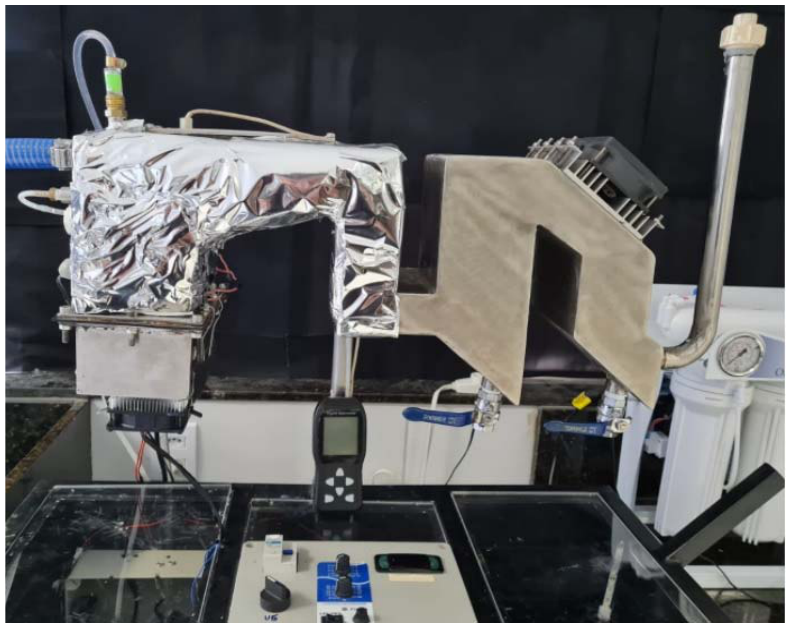
Figure 2. Bench ‐ scale prototype developed for ultrasonic treatment of boiler water. Figure 2. Bench-scale prototype developed for ultrasonic treatment of boiler